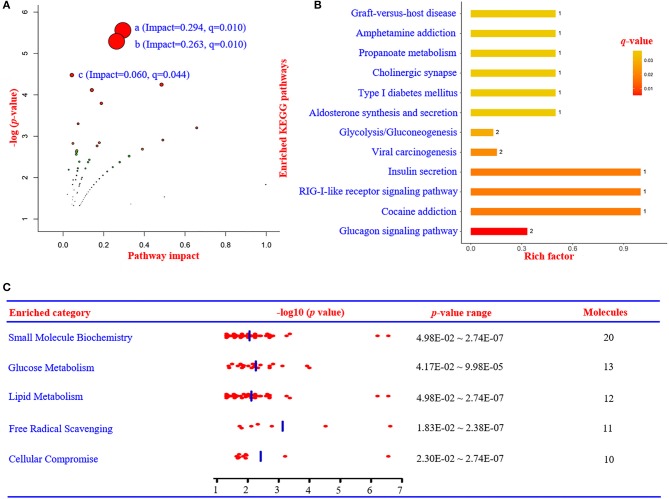
Summary of metabolic pathways based on metabolomics, proteomics, and integrated analysis. (A) Metabolic pathway analysis based on metabolomics data using IMPaLA. (a) Alpha-linolenic acid and linoleic acid metabolism (impact = 0.294, q = 0.010). (b) Incretin synthesis, secretion, and inactivation (impact = 0.263, q = 0.010). (c) Signal transduction (impact = 0.060, q = 0.044). (B) Enriched KEGG pathways based on proteomics data. (C) The most significant enriched function annotations analyzed by Ingenuity Pathways Analysis, based on the differentially expressed metabolites and proteins between patients with PDD and PD. KEGG, Kyoto Encyclopedia of Genes and Genomes; PDD, Parkinson's disease-related depression; PD, Parkinson's disease.